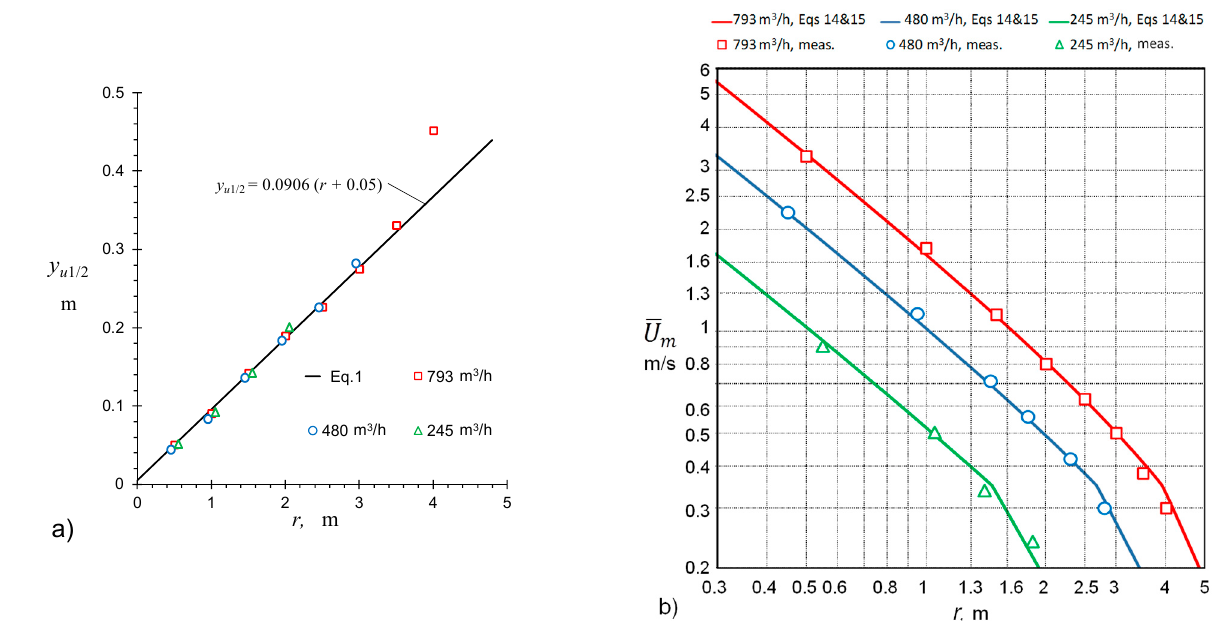
Figure 10. The results of air velocity distribution in RWJs for multi-cone diffuser at the reduced supply airflow rate to 60% and 30%. ( a ) The increase of the half-width yU1/2 of RWJs versus a radial distance r, compared with the results of a calculation using Equation (1); ( b ) the decay of maximum mean air velocity of RWJs versus a radial distance r, compared with the results of a calculation using Equations (14) and (15).